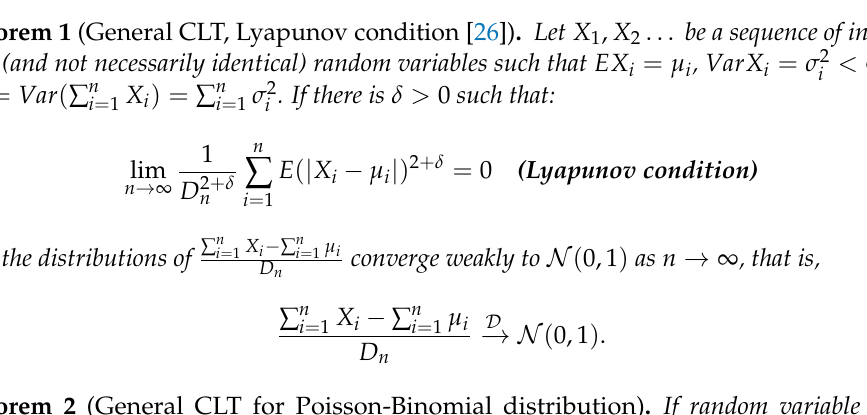
Figure 4. Distribution structure of the cumulative noise vector e ⊕ ¯e